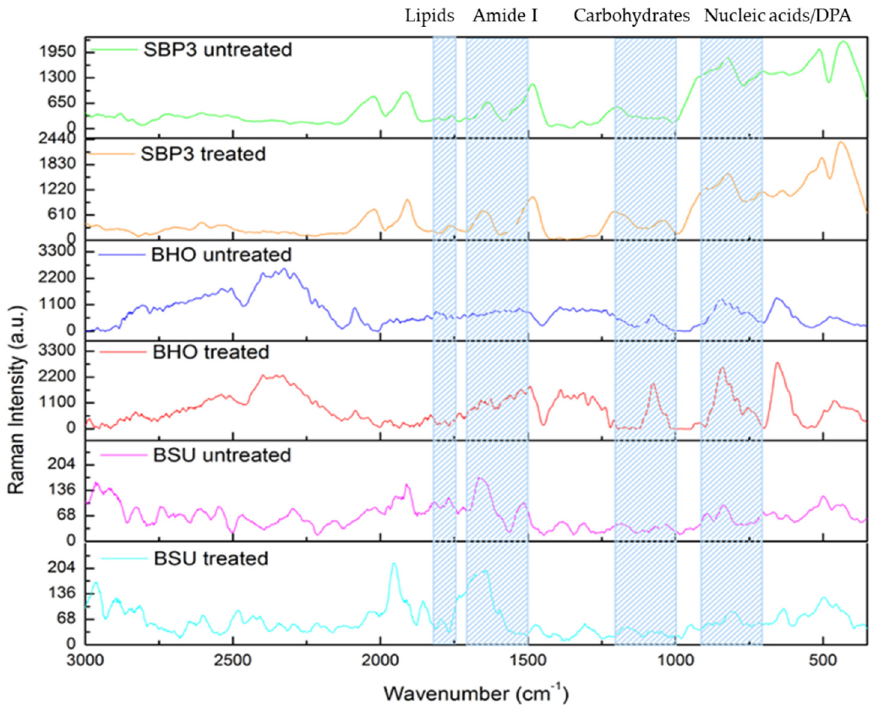
Figure 5. Raman spectra of untreated and wet-heat-treated spores from Bacillus horneckiae SBP3, Bacillus horneckiae DSM 23495T (BHO) and Bacillus subtilis 168 (BSU). To analyze the differences among the Raman spectra, a principal component analysis After treatment, changes in the Raman spectra were observed in the region of 800–900 cm − 1 (PCA) was performed, and Figure 6 reports the data. attributed to DPA and nucleic acids, with the highest variation detected in BHO and the lowest in SBP3 (Figure 5). Compared to untreated spores, the spectrum of treated BHO spores showed evident peak shifts in the regions that referred to amide I (1660–1674 cm − 1 ) and lipids (1700–1736 cm − 1 ). Unlike untreated SBP3 spores, the spectrum of heated spores showed higher variations in the amide I region, while moderate peak variations were detected in the region attributed to lipids (Figure